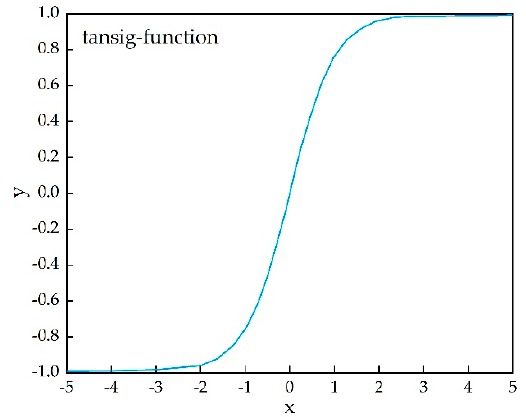
Figure 7. Tansig function curve.